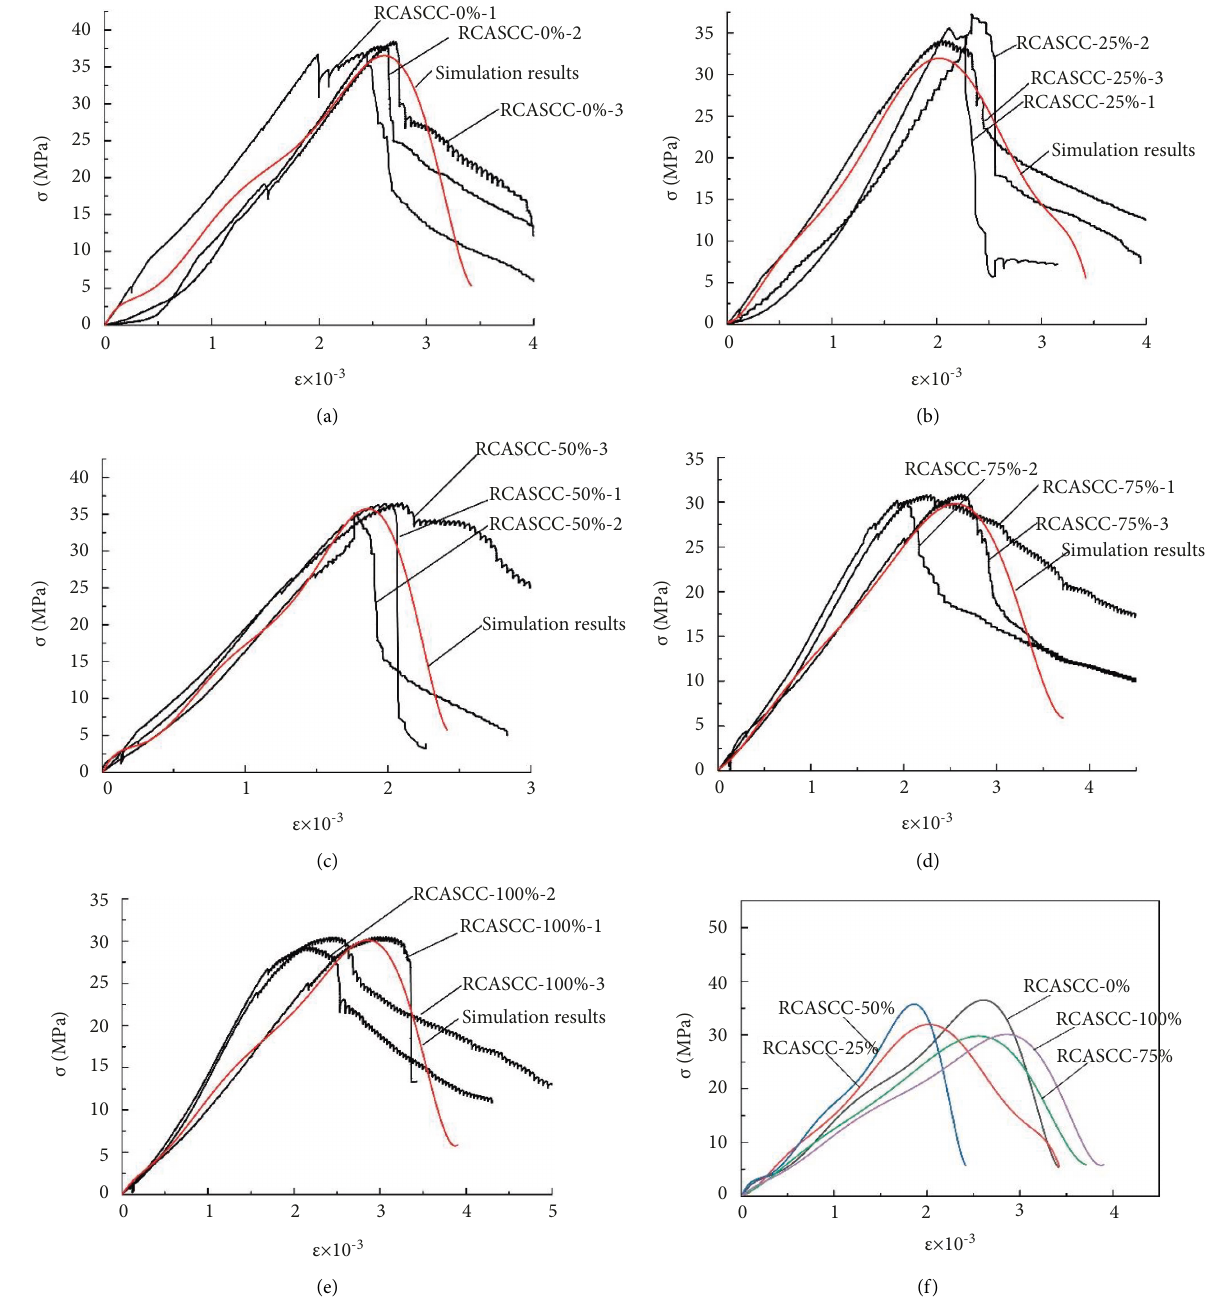
Figure 13: Stress-strain curves of RCASCC under uniaxial compression. (a) RCA substitution rate of 0%. (b) RCA substitution rate of 25%. (c) RCA substitution rate of 50%. (d) RCA substitution rate of 75%. (e) RCA substitution rate of 100%. (f) Stress-strain curves of